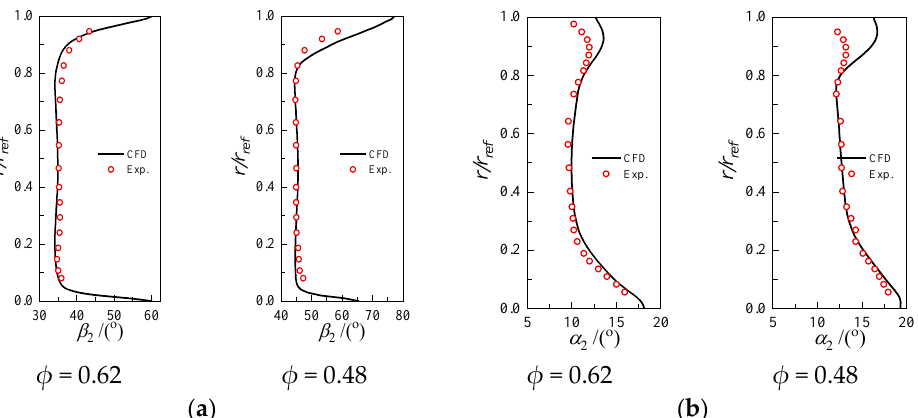
Figure 6. Comparison of rotor and stator flow angle between the experiment and numerical simulation: ( a ) rotor; ( b ) stator.